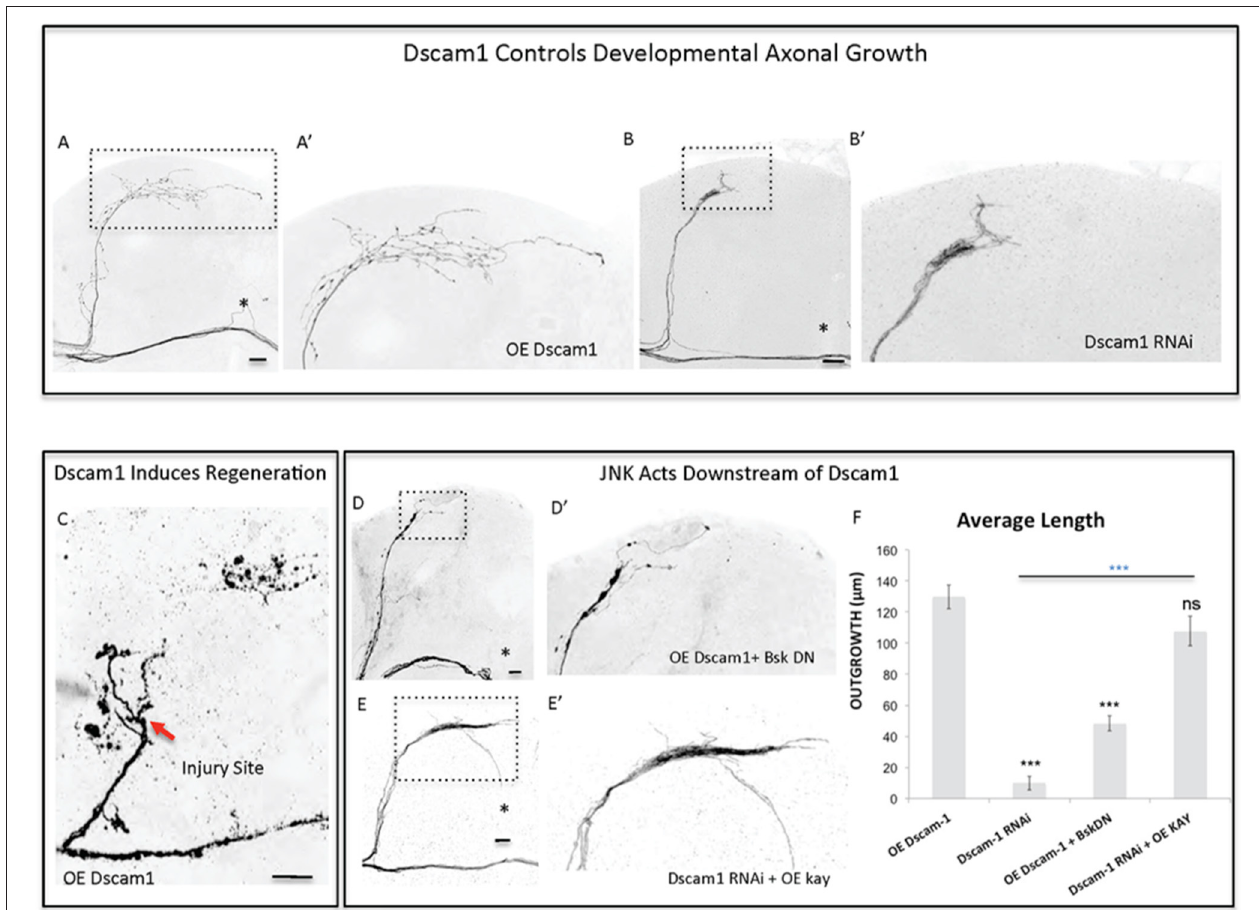
FIGURE 5 | Dscam1 promotes axonal outgrowth in development and axonal regrowth after injury, and interacts with the JNK signaling pathway. (A,B) Representative images of sLNv axonal arborization in adult flies where developmental overexpression of Dscam1 (A,A’), and Dscam1 RNAi (B,B’) has been specifically induced in the sLNvs. (C) Representative image of sLNv axonal regrowth 4 days after injury in flies where overexpression of Dscam1 has been specifically induced in the sLNvs. (D,E) Representative images of sLNv axonal arborization demonstrating that inhibition of Bsk accomplished by overexpression of a dominant negative line of Bsk inhibits Dscam1- induced outgrowth (D,D’) , and that overexpression of kay rescues the lack of axonal growth induced by overexpression of Dscam1-RNAi (E,E’) . (F) Morphometric analysis (Average Length) of sLNv axonal projections where developmental overexpression of Dscam1 ; Dscam1-RNAi; Dscam1 and Bsk DN; Dscam1-RNAi and kay , has been specifically induced in the sLNvs. Axonal outgrowth is measured in µ m. Genotype of flies in (A,A’,C) is PDF-Gal4, UAS-GFP/ + ; PDF-Gal4, UAS-2x eGFP/ + ; UAS-Dscam1-HA/ + , in (B,B’) is PDF-Gal4, UAS-GFP/ + ; PDF-Gal4, UAS-2x eGFP/ + ; UAS-Dscam1-RNAi/ + , in (D,D’) is PDF-Gal4, UAS-GFP/ + ; PDF-Gal4, UAS-2x eGFP/UAS-Bsk-DN; UAS-Dscam1-HA/ + , in (E,E’) is PDF-Gal4, UAS-GFP/ + ; PDF-Gal4, UAS-2x eGFP/ + ; UAS-Dscam1-RNAi /UAS-kay. Dotted insets have been zoomed in to better illustrate the diverse axonal phenotypes obtained. Asterisk denotes the brain midline, red arrow denotes the injury point. * p < 0.05; *** p < 0.001. n.s. indicates no statistical significance. Error bars represent SEM. Dotted insets have been zoomed in to better illustrate the diverse axonal phenotypes obtained. OE indicates overexpression. Scale bars are 20 µ m, with exception of C, which is 30 µ